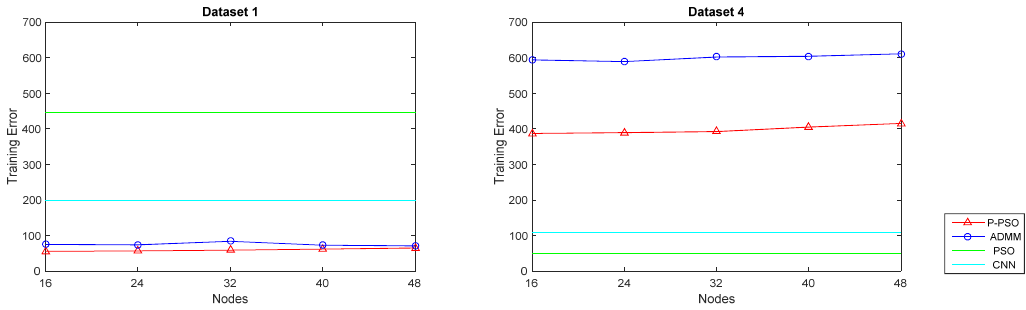
Figure 12. Training error comparison between traditional PSO, ADMM, CNN and P-PSO~based distributed ESN algorithms. A typical length of data size (1 × 10 5 ) is selected for the four